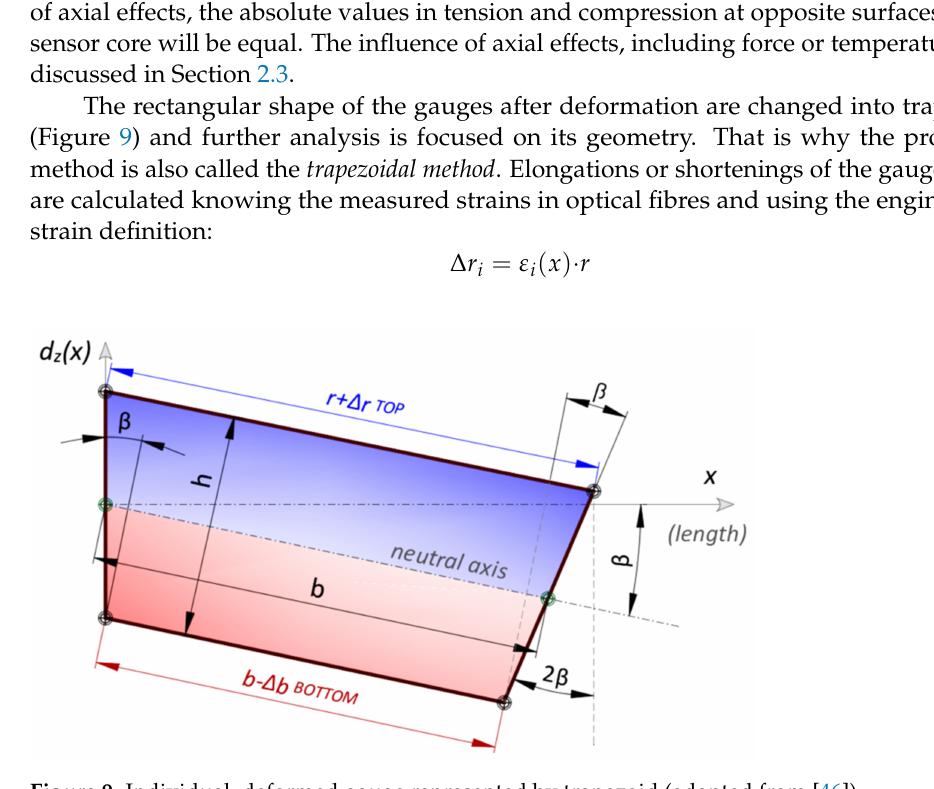
Figure 9. Individual, deformed gauge represented by trapezoid (adapted from [46]). To improve accuracy, strain values are averaged from two top and two bottom fibres. The sensitivity of the sensor to displacement changes can be improved by increasing